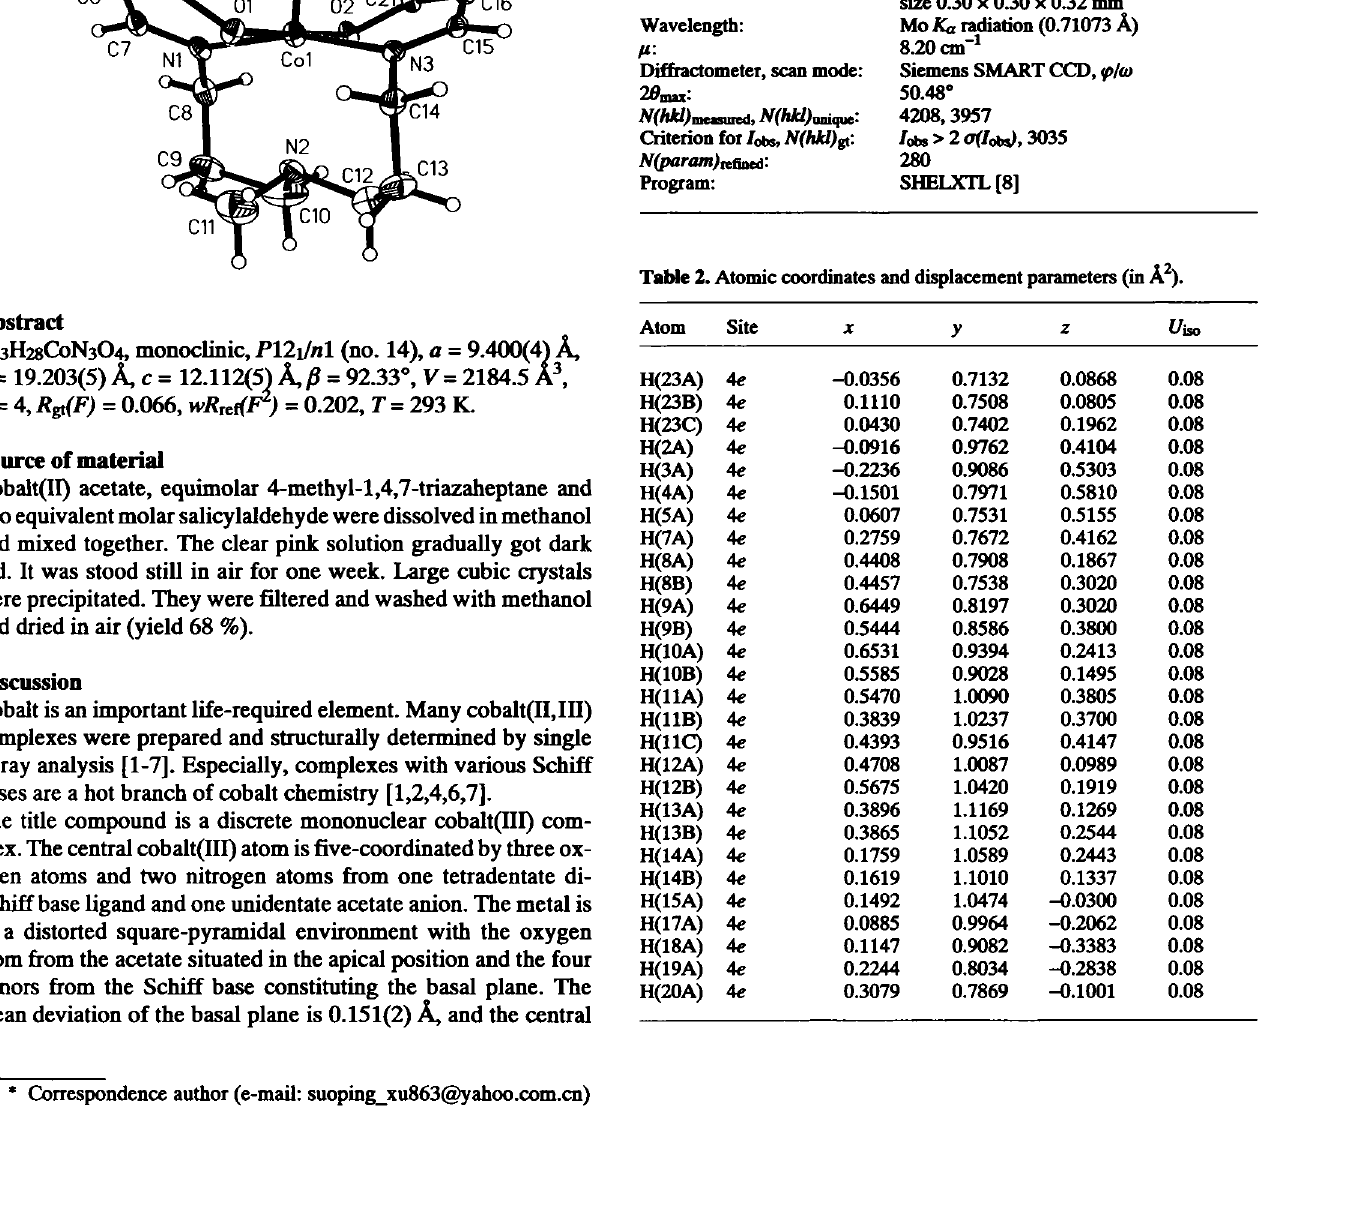
Table 1. Data collection and handling.